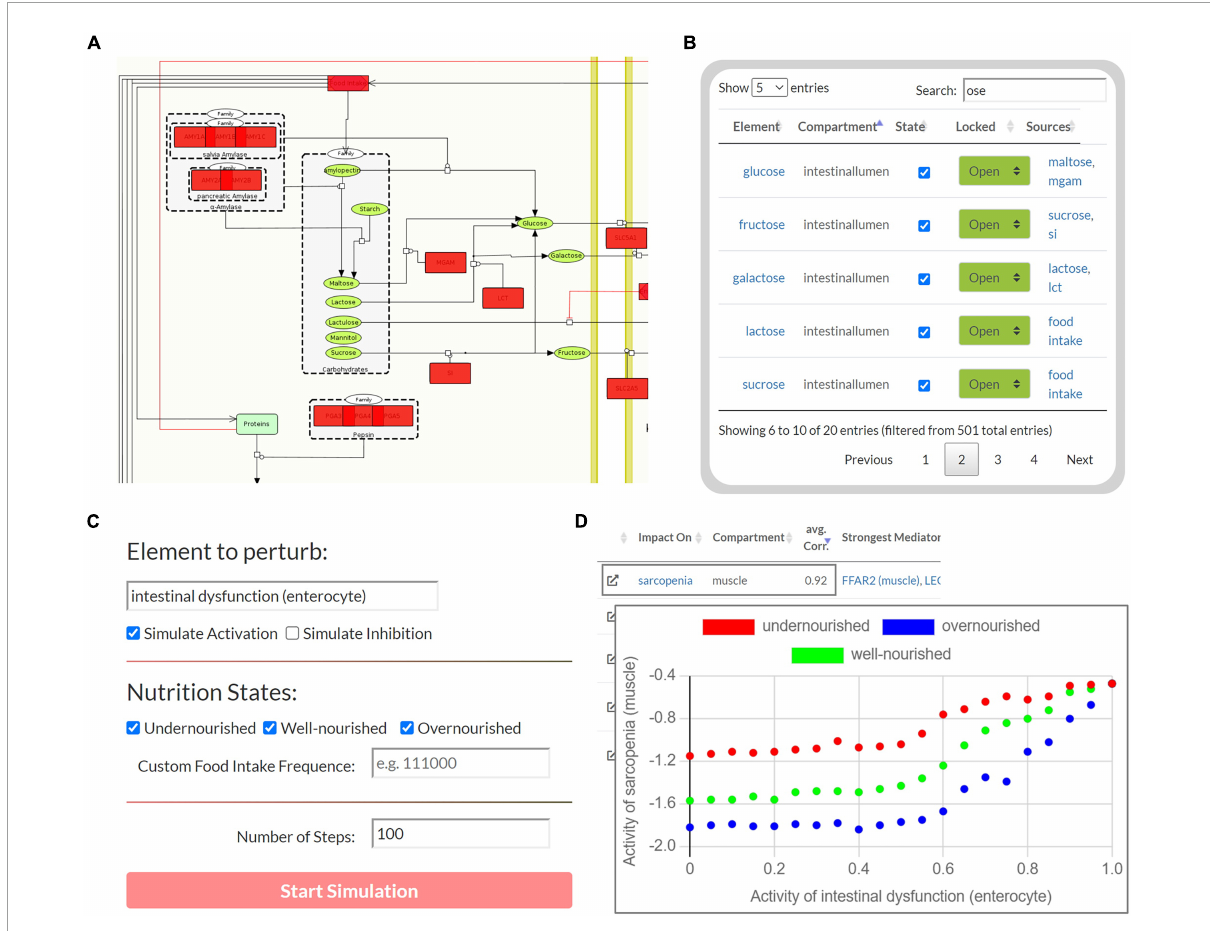
FIGURE4 The user interface to perform Boolean simulations on the Sarcopenia Map. (A) For each step, the active (red) or disturbed (gray) elements in the network are highlighted. (B) An interactive table provides an overview of all elements in the maps and allows perturbations by activating or inhibiting their state. (C) Automated perturbation experiments allow simulation of an increase in activation or inhibition of a selected element. (D) The correlation of the activities of the other elements in response to the perturbation is then presented in a table and